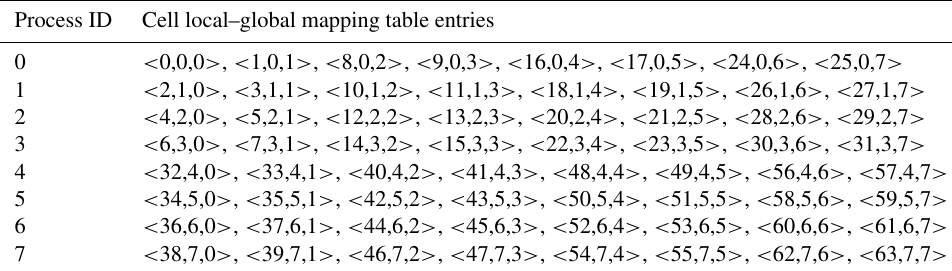
Table 1. The cell local–global mapping table (CLGMT) of the parallel decomposition in Fig. 1a. Process ID Cell local–global mapping table entries